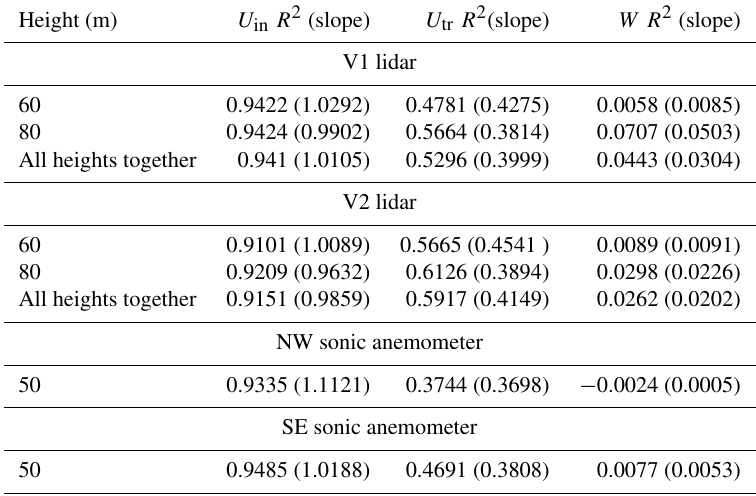
Figure 6. Linear regression of the 3-D velocity components retrieved from the triple RHI scans with the lidar profilers V1 and V2, and the NW and SE sonic anemometers for virtual tower 1 and all the considered heights. Table 8. Error analysis for the retrieval of the 3-D wind velocity from the triple RHI scans at virtual tower 2. Linear regression with wind measurements performed with the lidar profilers V1 and V2, and NW and SE sonic